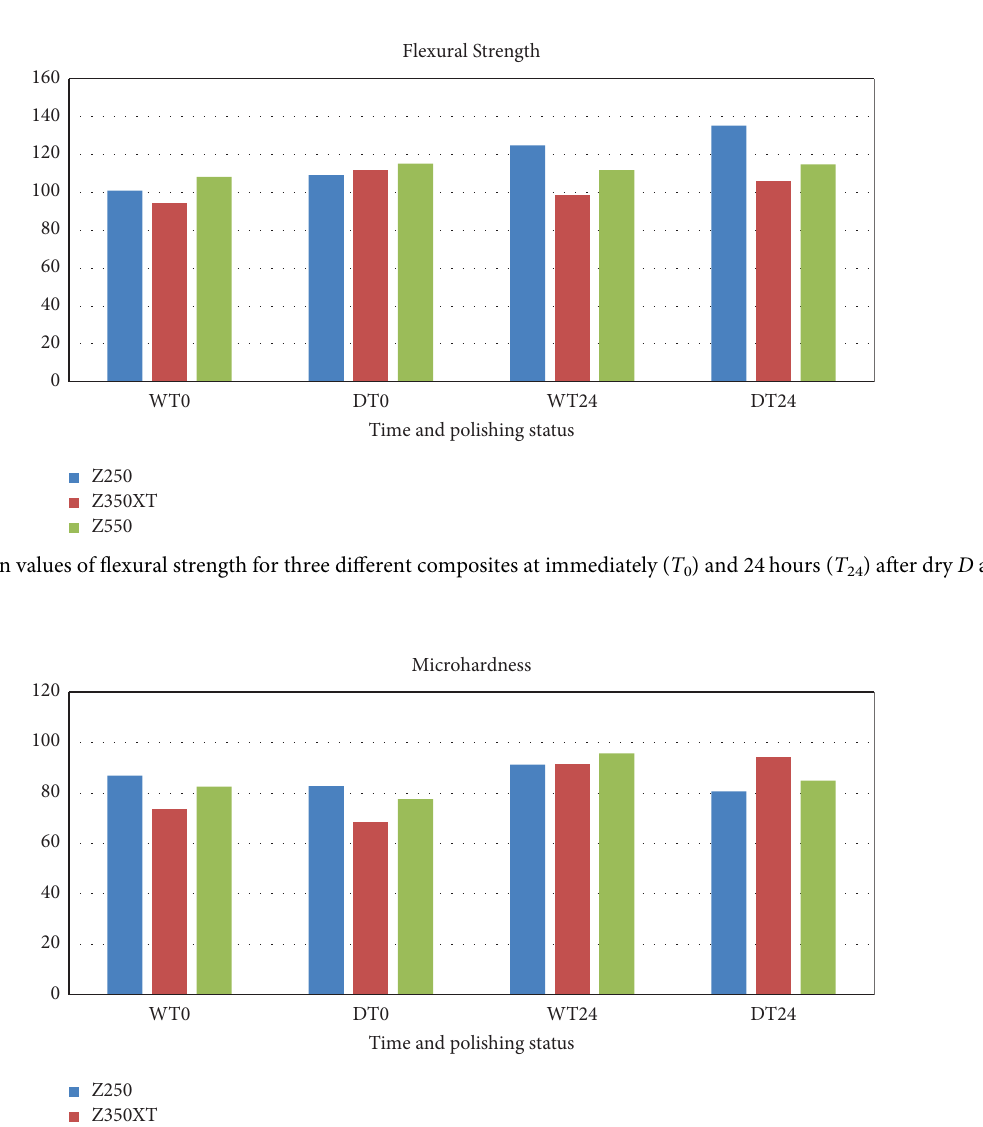
0 ) and 24 hours ( T 24 ) after dry D and wet W